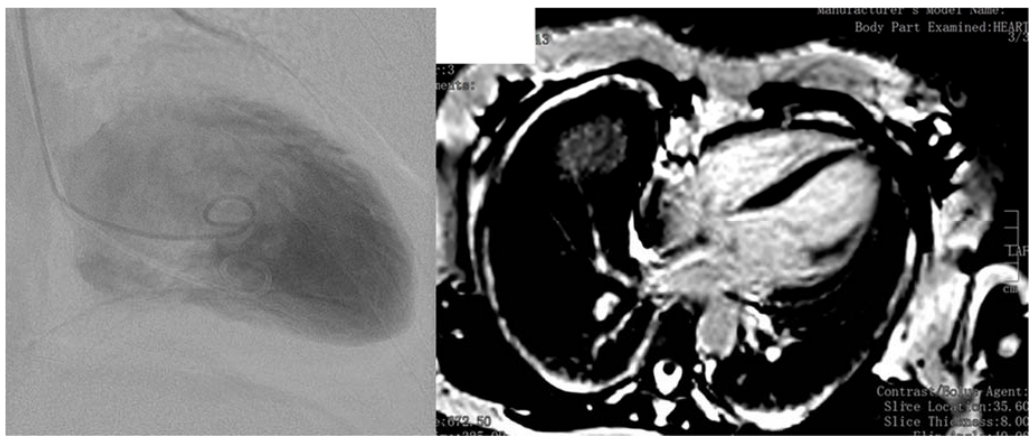
Figure 1. Ventriculography showing ballooning of the apical region of the left ventricle ( left panel ). Cardiac magnetic resonance imaging, 2 years after the initial event, showing no signs of late gadolinium enhancement ( right panel ).